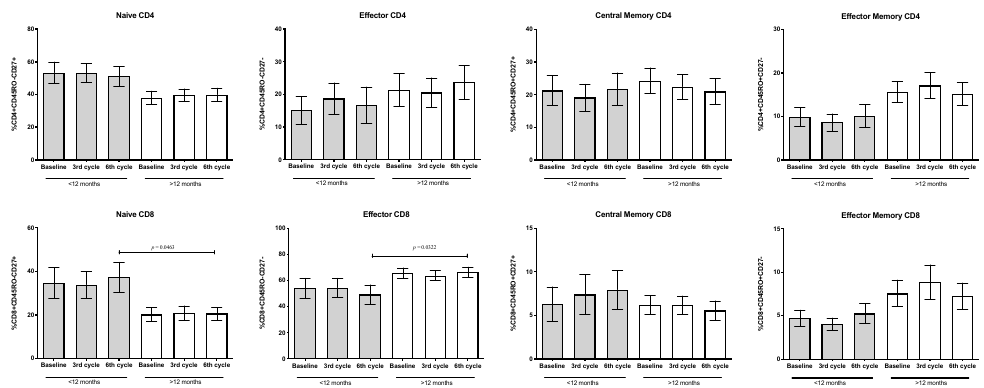
Figure 9. Percentages of naïve, effector and memory CD4+ and CD8+ T-lymphocyte subpopulations. Variations according to treatment cycle in groups with shorter (<12 months, n = 11) and longer (>12 months, n = 19) OS is shown. Mean ± SEM are shown.